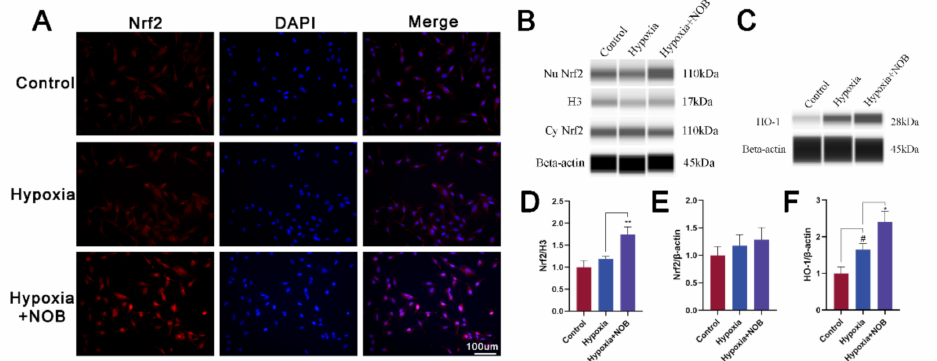
Figure 6. NOB promotes Nrf2 nuclear translocation and HO-1 upregulation in activated astrocytes induced by hypoxia for 24 h. ( A ) The Nrf2 immunofluorescence images of astrocytes in different groups. Scale bar, 100 µ m. ( B ) The levels of nuclear and cytoplasmic Nrf2 expression in astro- cytes after hypoxia of 24 h. ( C ) The levels of HO-1 expression in astrocytes after hypoxia of 24 h. ( D ) Quantification of nuclear Nrf2 normalized to H3. ( E ) Quantification of cytoplasmic Nrf2 nor- malized to β -actin. ( F ) Quantification of HO-1 normalized to β -actin. The data are presented as mean ± SD, n = 3, # p < 0.05 vs. control, * p < 0.05 and ** p < 0.01 vs. hypoxia